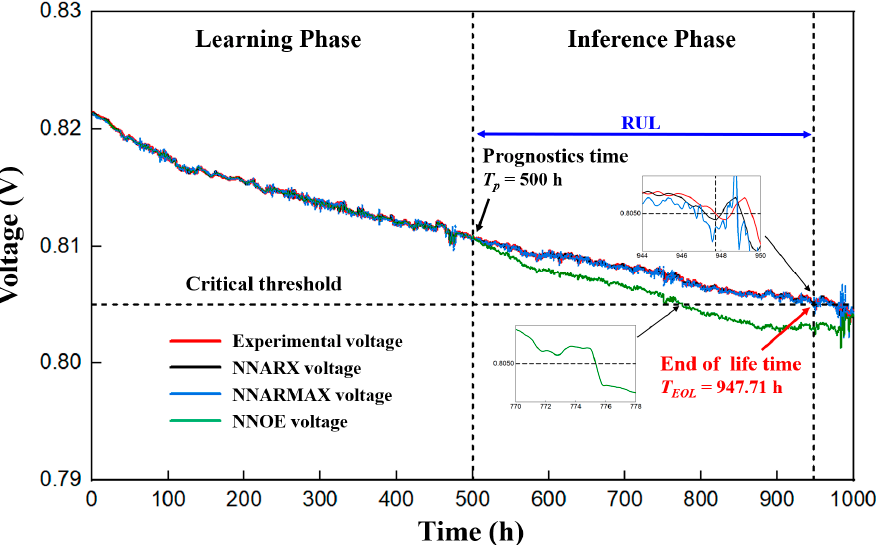
Figure 6. Comparison results of the SOFC degradation trend prediction and RUL estimation by different DNN models.